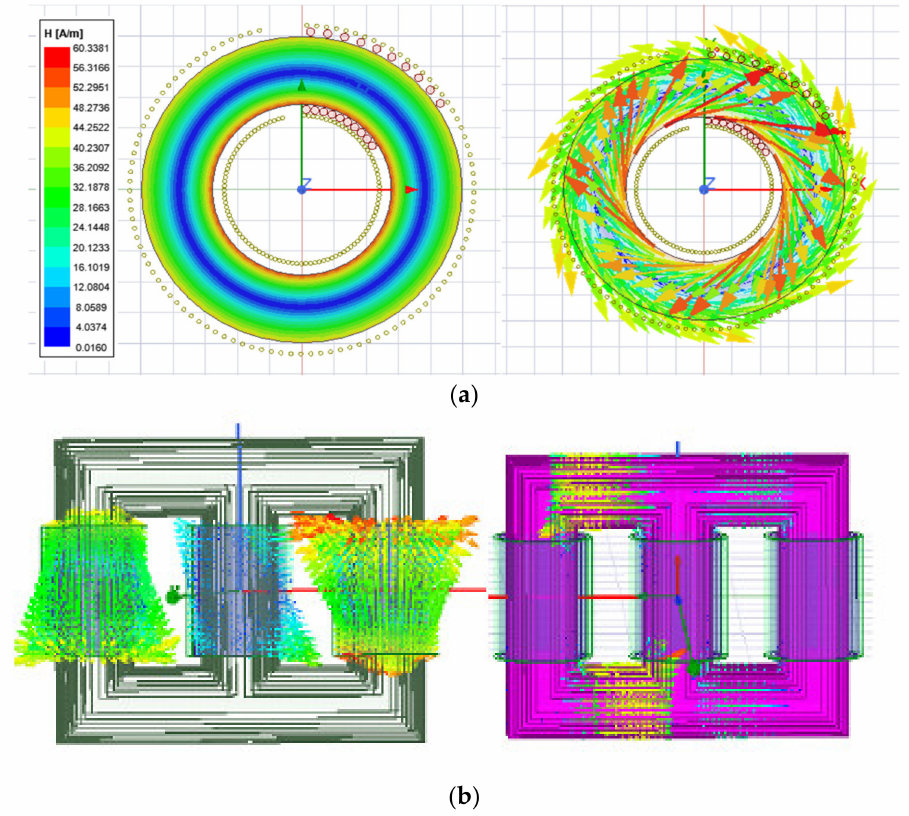
Figure 10. Magnetic Field Intensity Distribution ( a ) Toroidal transformer ( b ) shell-type